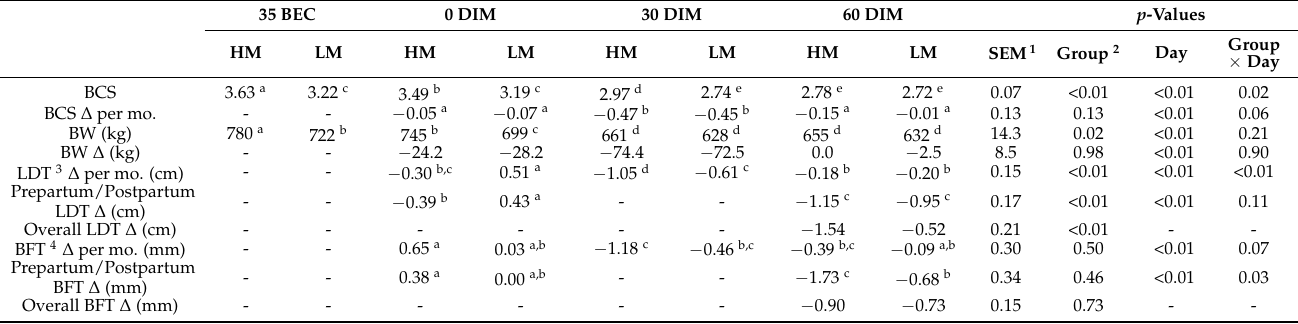
Table 2. Effect of high-muscle (HM; n = 20) and low-muscle (LM; n = 21) longissimus dorsi thickness (LDT) at 35 d before expected calving (BEC) on body condition score (BCS), bodyweight (BW), and respective changes in tissue thickness from 35 d BEC through 60 d in milk